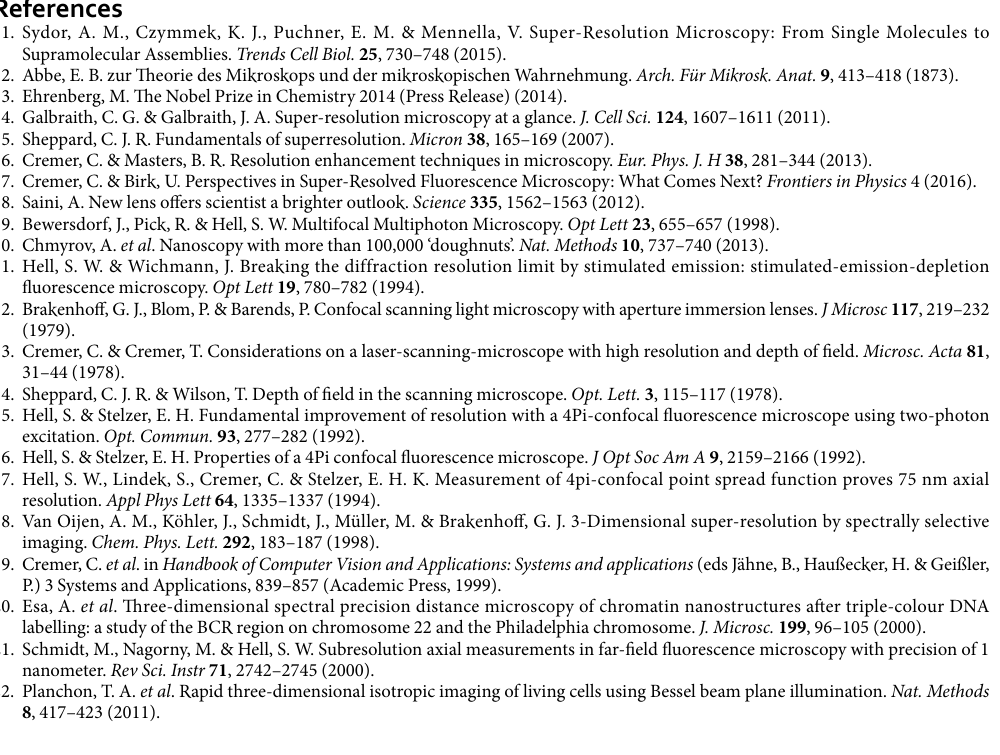
The equations used throughout the manuscript to calculate the intensity distribution generated by multi- ple coherent light sources are described in Supplementary Note 3 for both the vector and the scalar/Feynman approach. The differences in the results for the two approaches are discussed in Supplementary Note 1. The colli- mated light sources in practice are taken to be Gaussian beams with the beam waist at the position of the nominal target site (the origin). Alternatively, other realistic representations of the beams such as e.g. Bessel beams could be used, as demonstrated successfully in the lattice light-sheet microscope developed in the Betzig lab 23 .